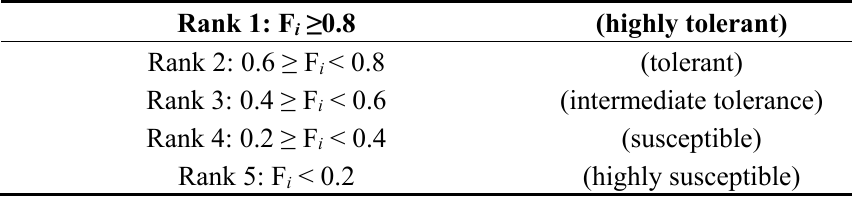
Table 2. Aluminum tolerance membership